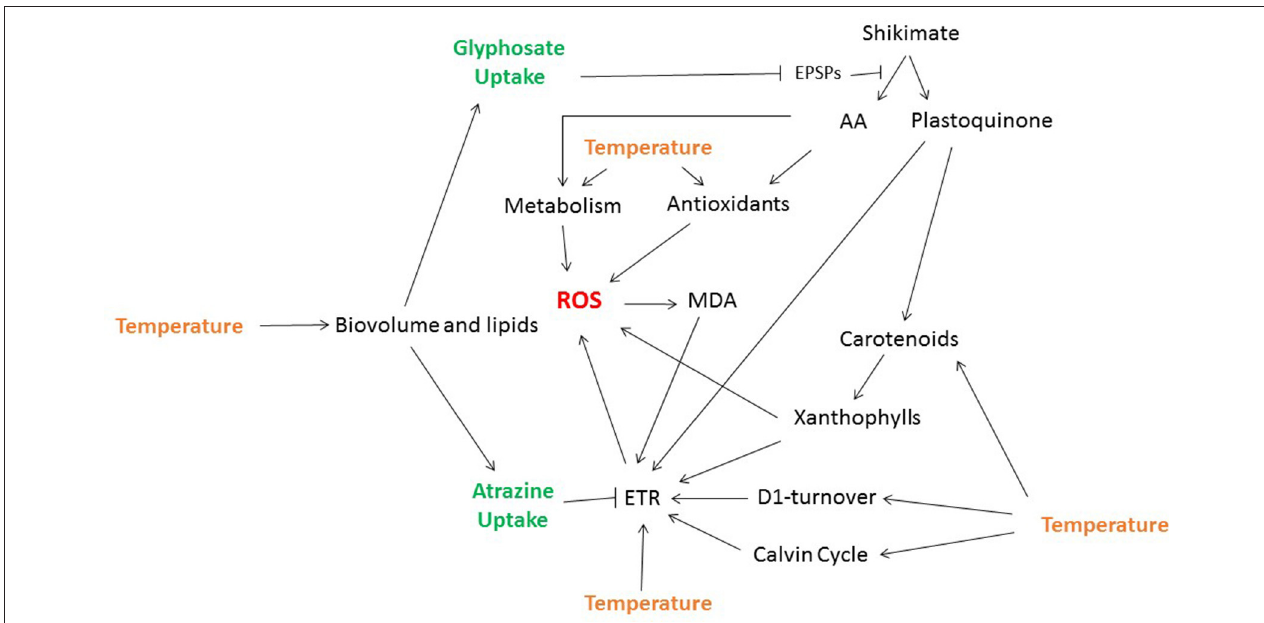
FIGURE 1 | Effects of temperature on the toxic effects of glyphosate and atrazine on photosynthetic aquatic organisms. Both glyphosate and atrazine can induce reactive oxygen species (ROS) accumulation, which will increase lipid peroxidation (MDA) and lead to oxidative bursts and membrane destruction (thylakoids), thus contributing to decreases in photosynthetic rates (ETR). Temperature can modulate the deleterious effects of atrazine and glyphosate exposure by: (1) inducing changes in cell biovolumes and lipid composition, and therefore herbicide uptake; (2) modulating enzymatic activity, including antioxidant systems and cell respiratory metabolism (which are both related to ROS content), as well as D1-protein recovery and the Calvin Cycle (which are involved in ETR and photosynthetic rates); (3) modulating pigment contents, especially of carotenoids, which are linked to thermal dissipation capacity, ROS, and the synthesis of xanthophylls; and (4) modulating membrane fluidity and the diffusion of electron carriers (which are related to